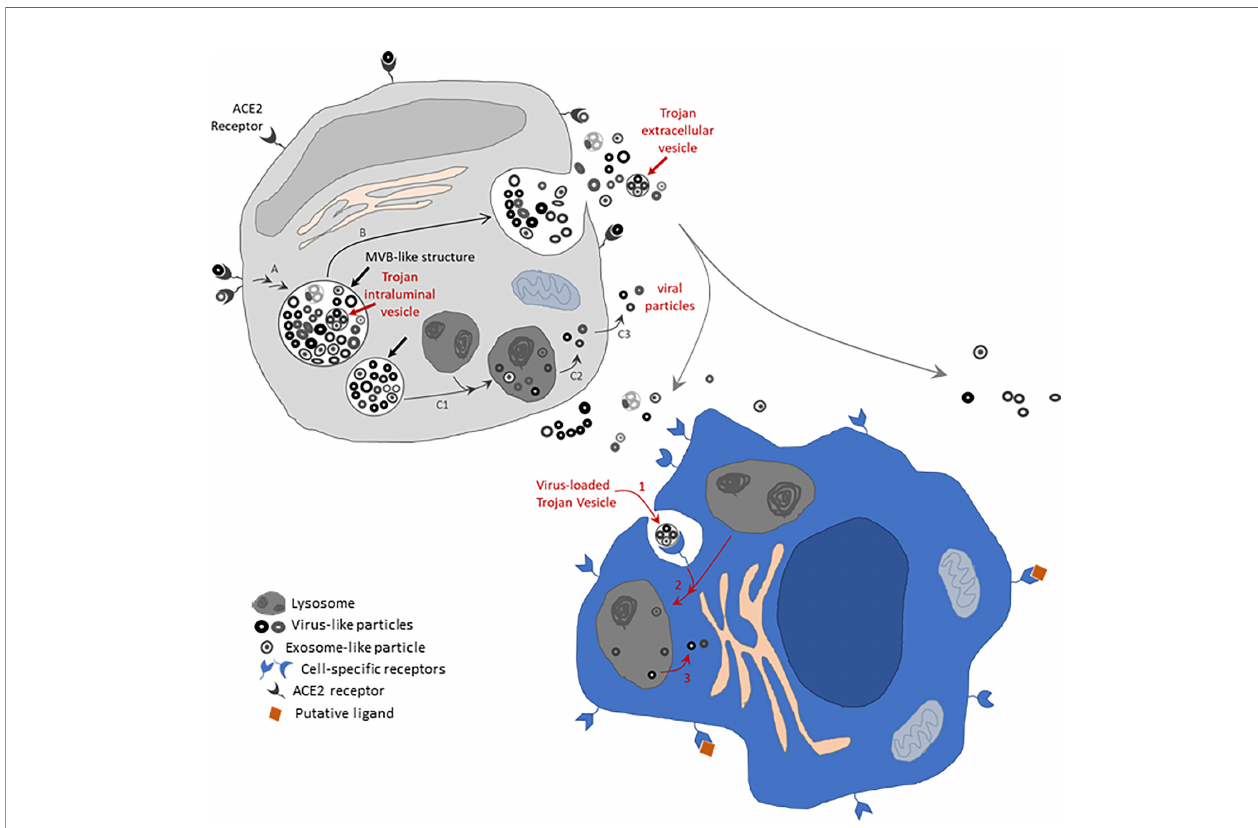
FIGURE 1 | Schematic of EV-mediated mechanism potentially contributing to SARS-CoV-2 infectivity. Membrane bound structures containing virus-like and exosome-like particles of distinct electron densities and diameters (thick straight black arrows) are shown in the putative grey cell, resembling those structures identi fi ed by electron microscopy by Zhu and colleagues (34). These structures resemble multivesicular body (MVB)-like structures. The thick straight red arrow indicates an intraluminal vesicle-like structure that contains smaller nanoparticles [reminiscent of intraluminal vesicles possibly containing hidden viral particles – this also resembles a structure apparently observable in electron micrograph from (34)]. These MVB-like structures might have originated via the endosomal pathway after initial internalization of SARS-CoV-2 particles via the ACE2 receptor in expressing cells (entry route A). The MVB-like structures might proceed to fuse with the cell membrane, therefore spilling their content in the extracellular space (route B). Alternatively, they might fuse with lysosomes and consequently allow scape of the viral particles as suggested by (40) (route C1-C2-C3). Released Trojan extracellular vesicles (EVs) carrying virus-like particles may potentially be internalized by cells not expressing the ACE2 receptor but via cell-speci fi c receptors that recognize speci fi c membrane markers in the Trojan EVs. Internalized Trojan EVs may potentially infect the invaded cells (putative blue cell) by exploiting a mouse hepatitis virus (MHV)-like mechanism (40) via fusion with lysosomes (route 1-2-3 in blue cell). Drawings not done to scale. Membrane proteins expected to be present in viral particles and EVs that are expected to contribute to viral and Trojan EV docking are not drawn. Receptors are drawn as exaggeratedly large features on the cell surface to highlight known (ACE2 receptor-mediated) and potential (Trojan EV receptor- mediated) receptor-speci fi c mechanisms. Trojan EVs might further contribute to SARS-CoV-2 infectivity by transferring ACE2 receptors and other viral molecules to non-expressing cells (not